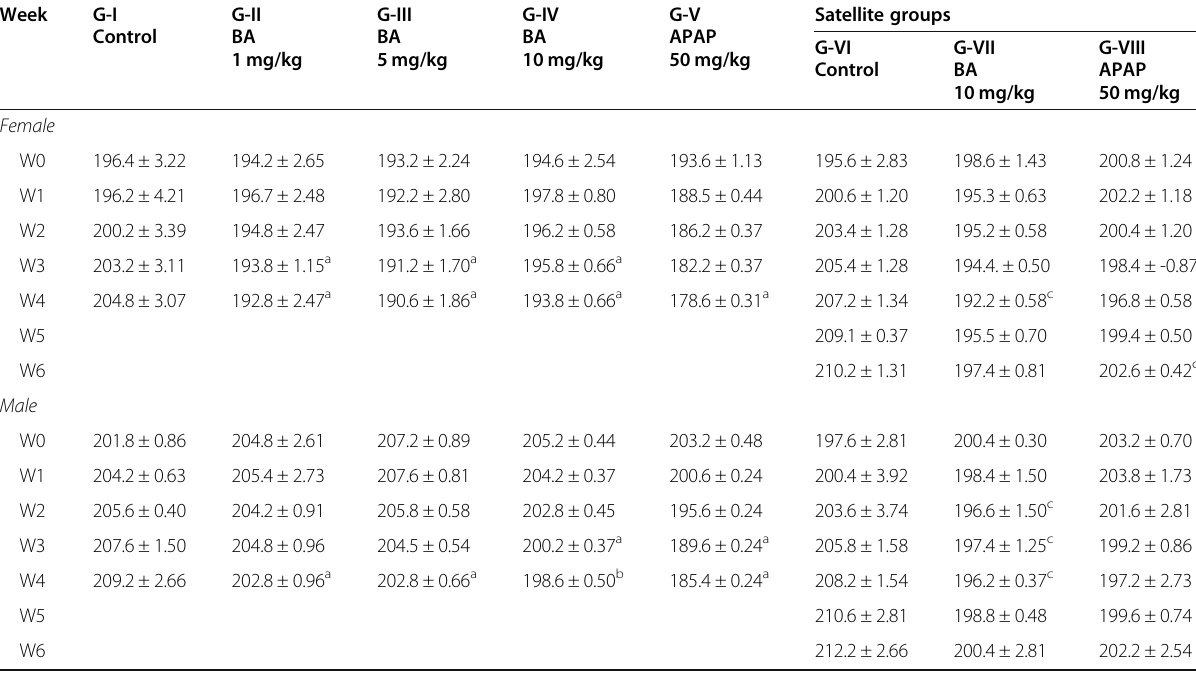
Table 1 Effect of sub-acute oral administration of BA and APAP on body weight (g) of Wistar rats ( n = 5/sex) Week G-I